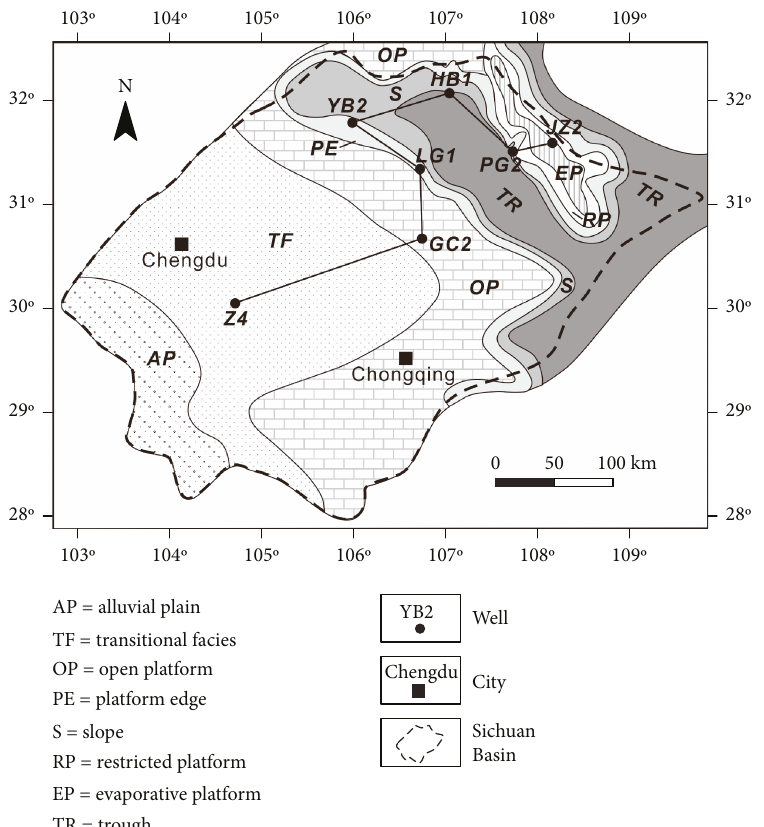
Figure 2: Key wells and sedimentary facies in the upper part of the second member of the Feixianguan Formation (T (modi fi ed from